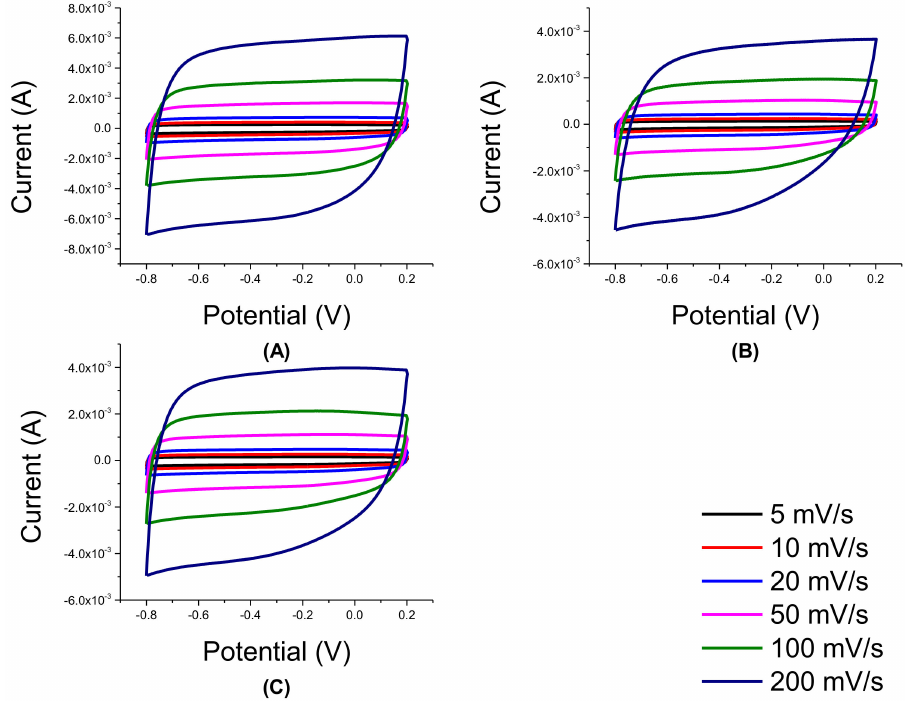
Figure 11. CV of rGO/TNT: ( A ) 3:1, ( B ) 1:1, and ( C )